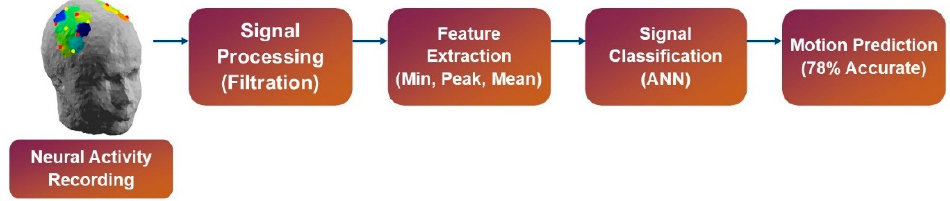
Figure 5. Flow diagram of fNIRS-based motion intention recognition for the transhumeral prosthe-